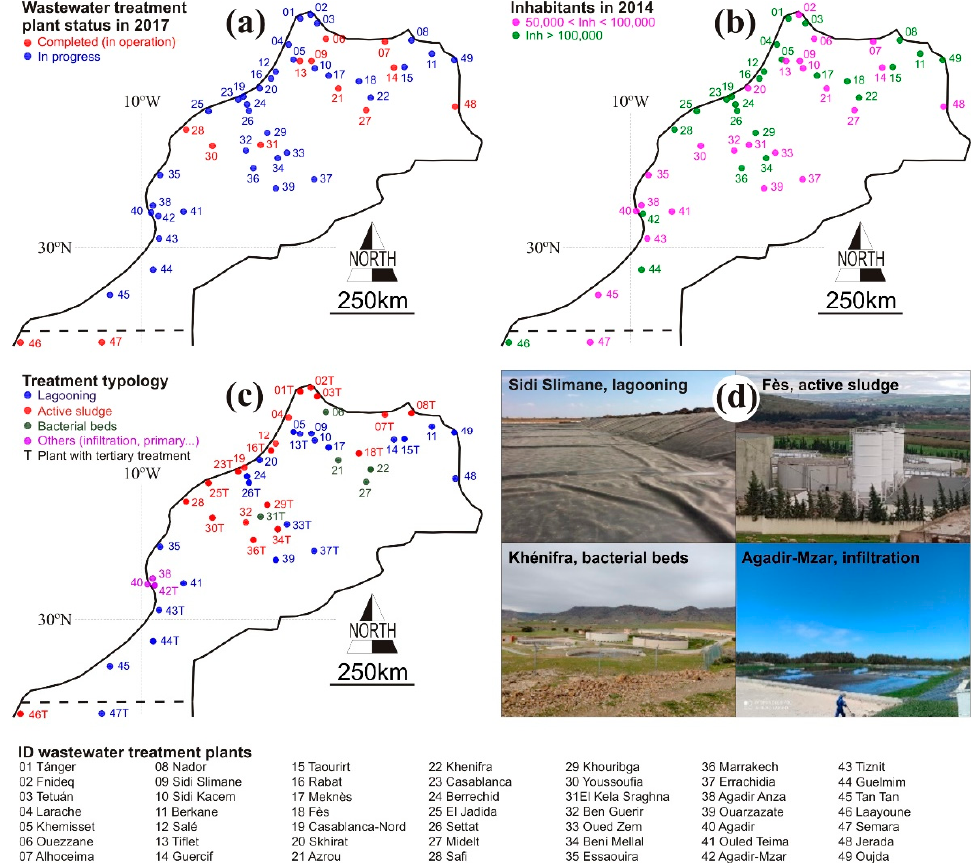
Figure 5. Urban wastewater treatment plants in Morocco after the PWNOW database (accessed on January 2017). ( a ) Completed (in operation) and in-progress treatment plants, as in Figure 1d. ( b ) Classification of treatment plants attending to inhabitants reported by the High Commission for Planning of Morocco [70]. ( c ) Classification of the treatment plants attending to the implemented treatment technology, identifying also those plants with operative tertiary treatment. ( d ) Photos showing the typology of some treatment plants.